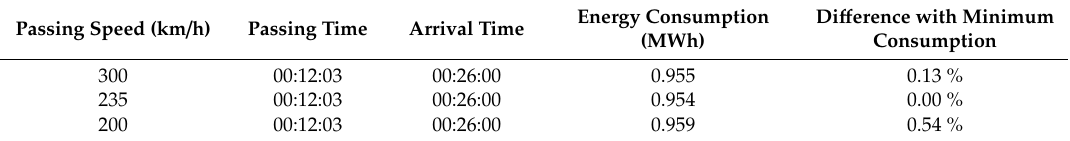
Table 4. Results of the speed profiles obtained for di ff erent values of passing speed at 264 km. Passing Speed (km / h)